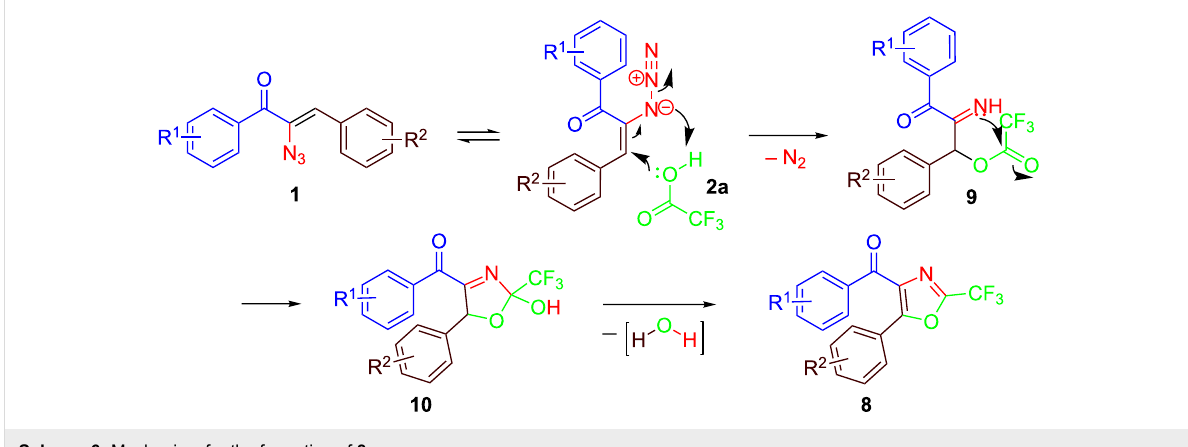
Scheme 6: Mechanism for the formation of 8